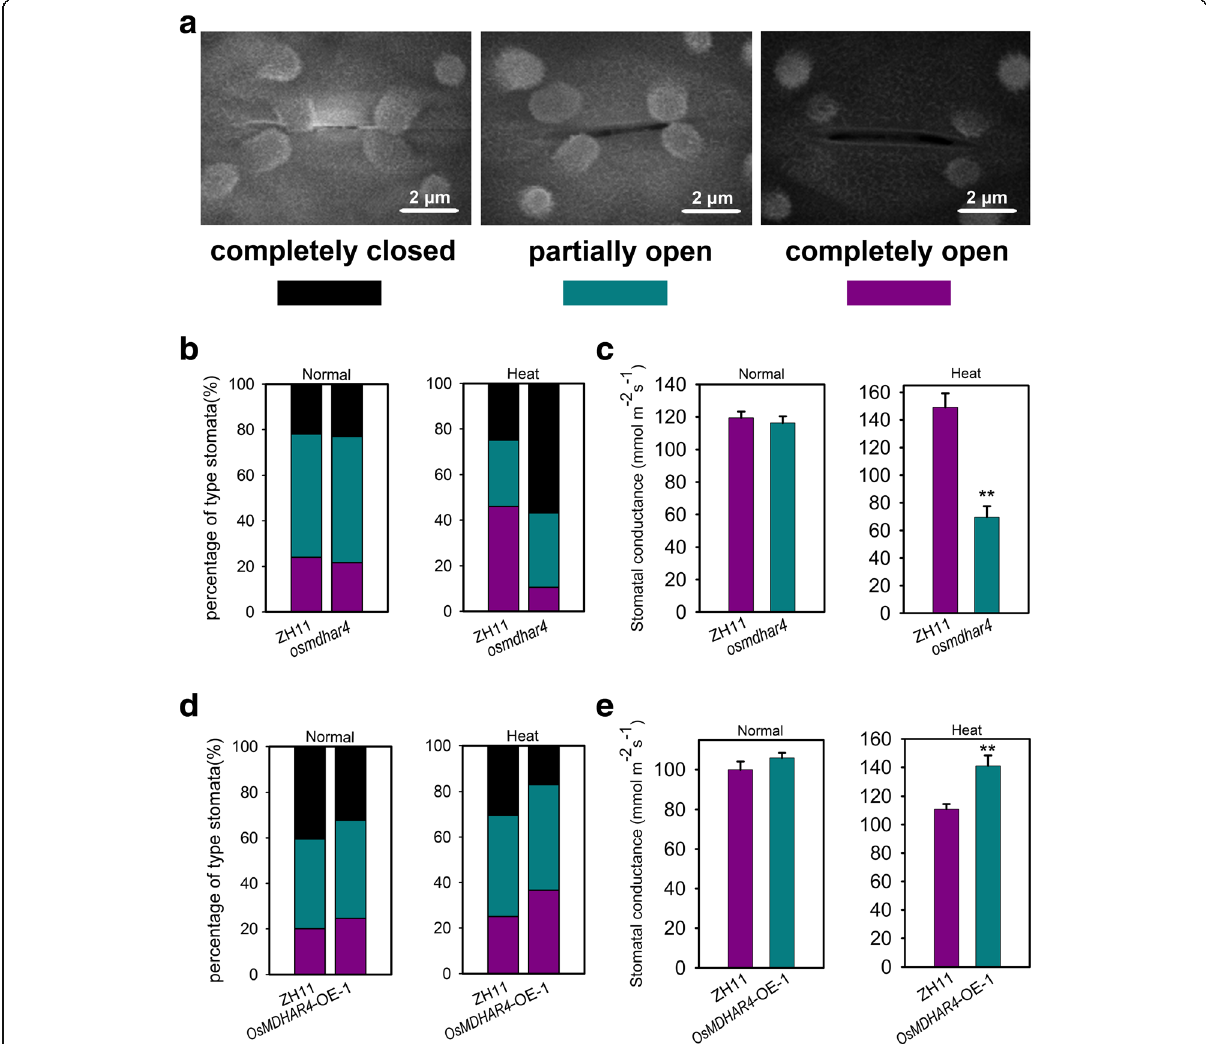
Fig. 5 The stomatal aperture status in the osmdhar4 mutant and OsMDHAR4 -overexpressing plants. a Scanning electron microscopy images of three levels of stomatal opening. Scale bars = 2 μ m. b Percentages of three levels of stomatal opening in WT and the osmdhar4 mutant under normal conditions (48 stomata for WT, 40 stomata for the osmdhar4 mutant) and heat stress conditions (28 stomata for WT, 25 stomata for the osmdhar4 mutant). c Stomatal conductance of WT and osmdhar4 mutant under normal conditions and heat stress conditions (3 repeats, 12 plants in each repeat). d Percentages of three levels of stomatal opening in WT and OsMDHAR4 -OE-1 plants under normal conditions (70 stomata for WT, 90 stomata for OsMDHAR4 -OE-1) and heat stress conditions (60 stomata for WT, 76 stomata for OsMDHAR4 -OE-1). e Stomatal conductance of the WT and OsMDHAR4 -OE-1 under normal conditions and heat stress conditions (3 repeats, 12 plants in each repeat). FW, Fresh Weight. Error bars indicate the SE based on three biological replicates. *, P < 0.05, and **, P < 0.01, by Student ’ s t